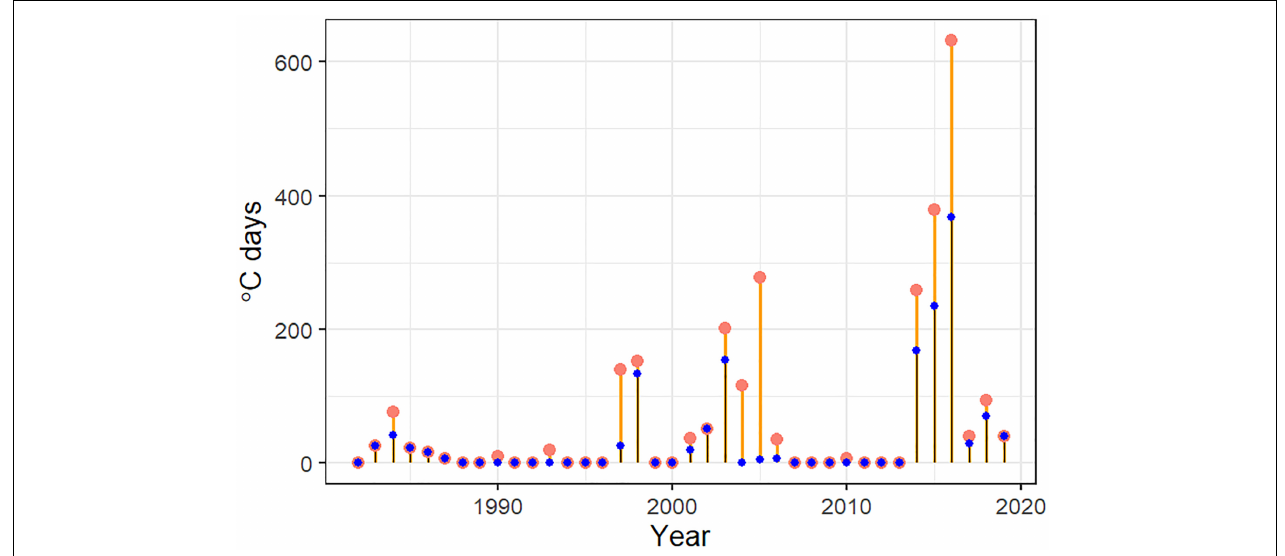
FIGURE 2 | Index of the sum of the annual marine heatwave cumulative intensity ( ◦ C days) for 1981–2019 (larger red points) and index of the sum of the annual winter marine heatwave cumulative intensity for 1981–2019 (smaller blue points) from the daily mean sea surface temperatures NOAA high-resolution blended analysis data for the central Gulf of Alaska. The 2019 index value is the sum through 26 February